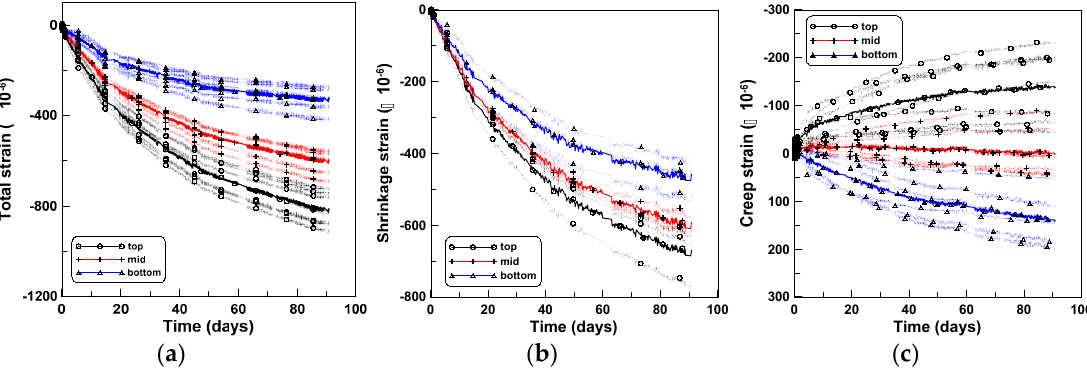
Figure 9. Strains at top, middle, and bottom surfaces (TP-3): ( a ) total, ( b ) shrinkage, and ( c ) creep.